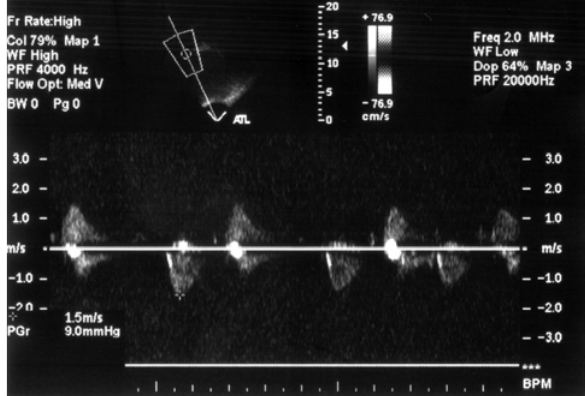
Fig. 3 – Curva de Doppler contínuo do fluxo aórtico